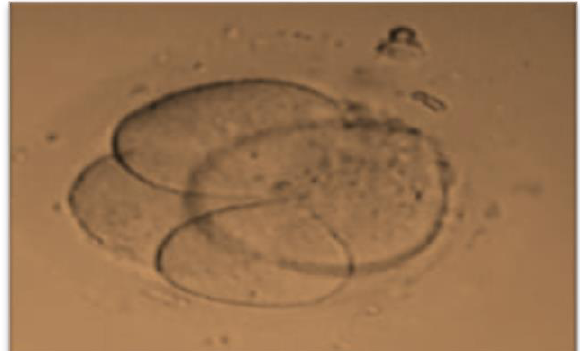
Figure,3: 2 cells Embryo (10x )